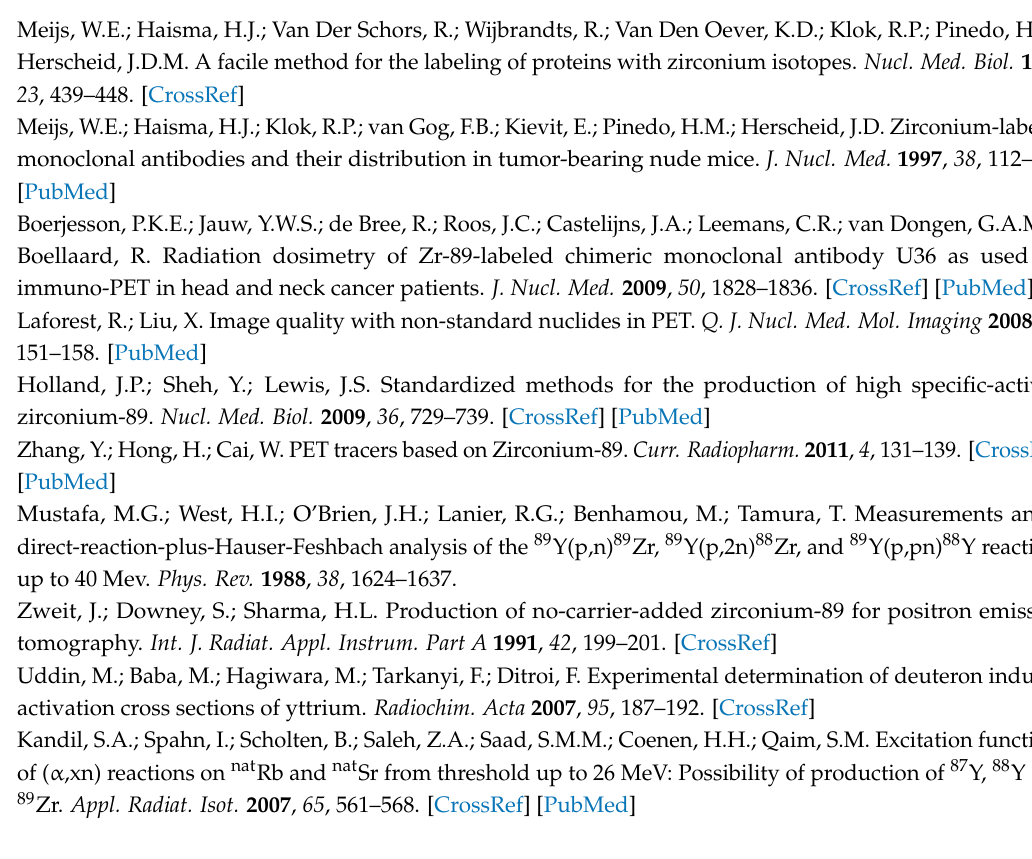
Figure S1: Solid target assembly, Figure S2: Remote-controlled automated cassette-based module for 89 Zr-oxalate. Table S1: Elements analyzed by ICP-MS for 89 Zr-oxalate produced by cyclotron using 89 Y-foil and pressed